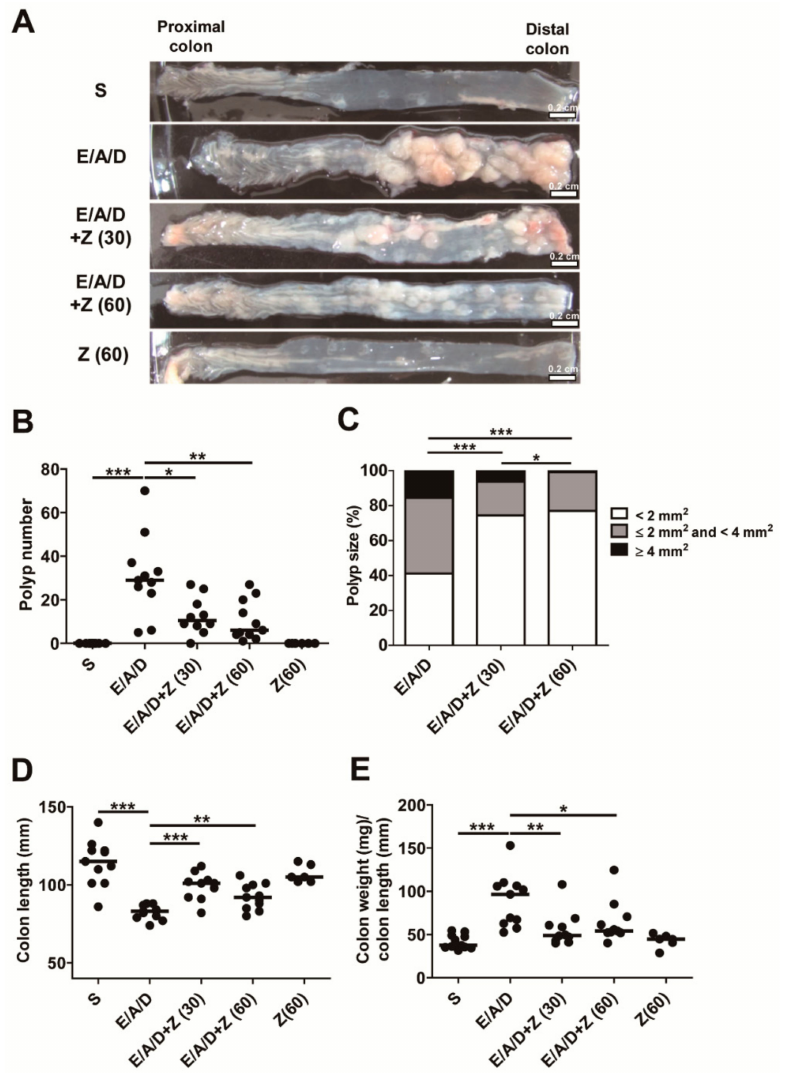
Figure 2. Zerumbone reduced ETBF-mediated tumorigenesis in AOM / DSS mice. AOM-treated BALB / c mice were infected with ETBF and subjected to two cycles of DSS (1%) for 9 weeks. During two DSS cycles, BALB / c mice were given zerumbone (30 and 60 mg / kg, p.o., three times a week). ( A ) Representative gross macroscopic image of the colon. ( B ) Polyp number. ( C ) Polyp size distribution. ( D ) Colon length (mm) and ( E ) colon weight (mg) / colon length (mm) ratio. Polyp number, polyp size distribution, colon length and colon weight / colon length ratio were measured on the last day of ETBF / AOM / DSS-treated experiments. S, sham control; E, ETBF; A, AOM; D, DSS; Z (30), Zerumbone (30 mg / kg) and Z (60), Zerumbone (60 mg / kg). Each dot represents one mouse. Scatter plot. Horizontal bar, median. * p < 0.05, ** p < 0.01, *** p < 0.001. ns, no statistical